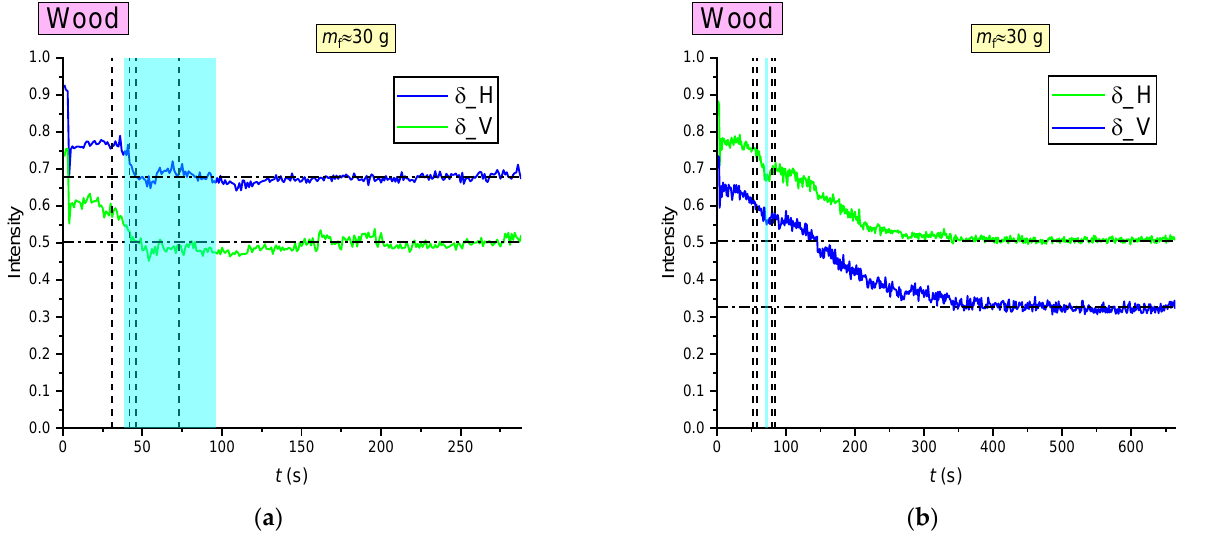
Figure 17. Change in δ when reproducing the conditions of improper use of heating equipment (hot plate) for the model fires consisting of wood with different duration of extinguishment: ( a ) 60 s; ( b ) 5 s.